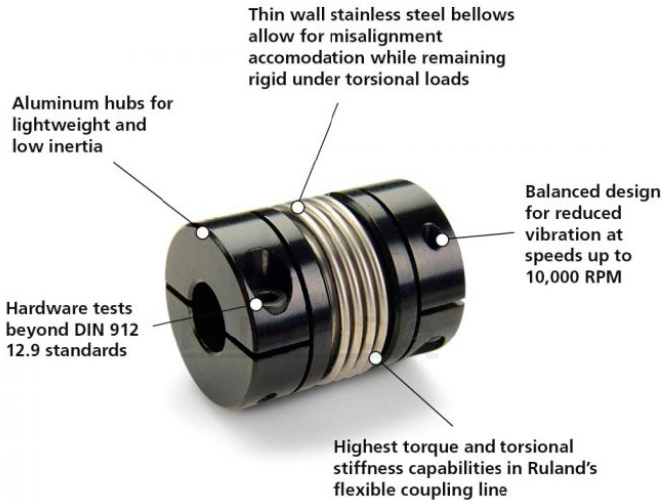
Figure 26. Flexible coupling properties (main features).